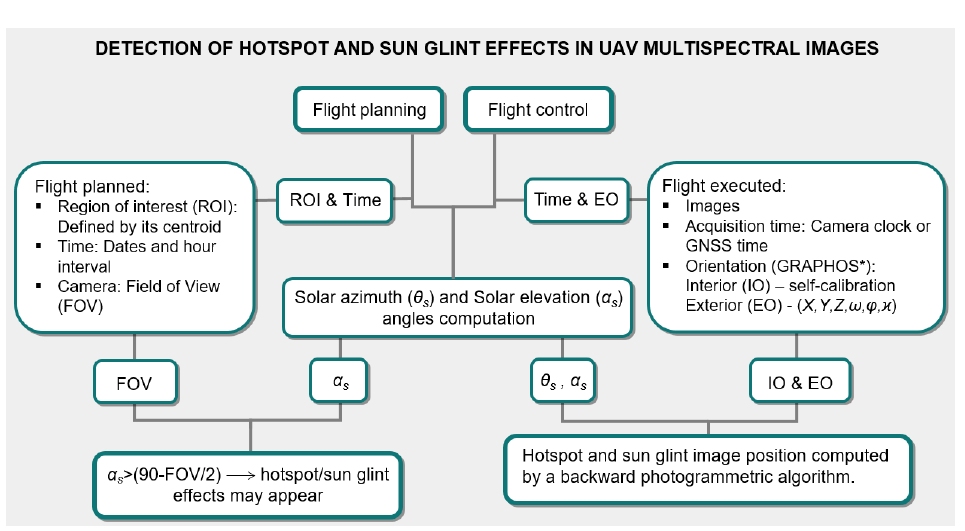
Figure 1. Workflow of the method developed for hotspot and sun glint detection in Unmanned Aerial Vehicle (UAV) multispectral images. * GRAPHOS (inteGRAted PHOtogrammetric Suite) is an open source software for photogrammetric applications developed by the authors.